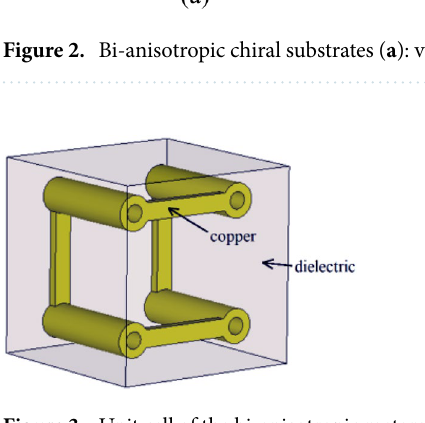
Figure 3. Unit cell of the bi-anisotropic metamaterial medium described by Eq. 2. The copper is inserted in a dielectric medium with a relative permittivity ε r = 2.2. 28